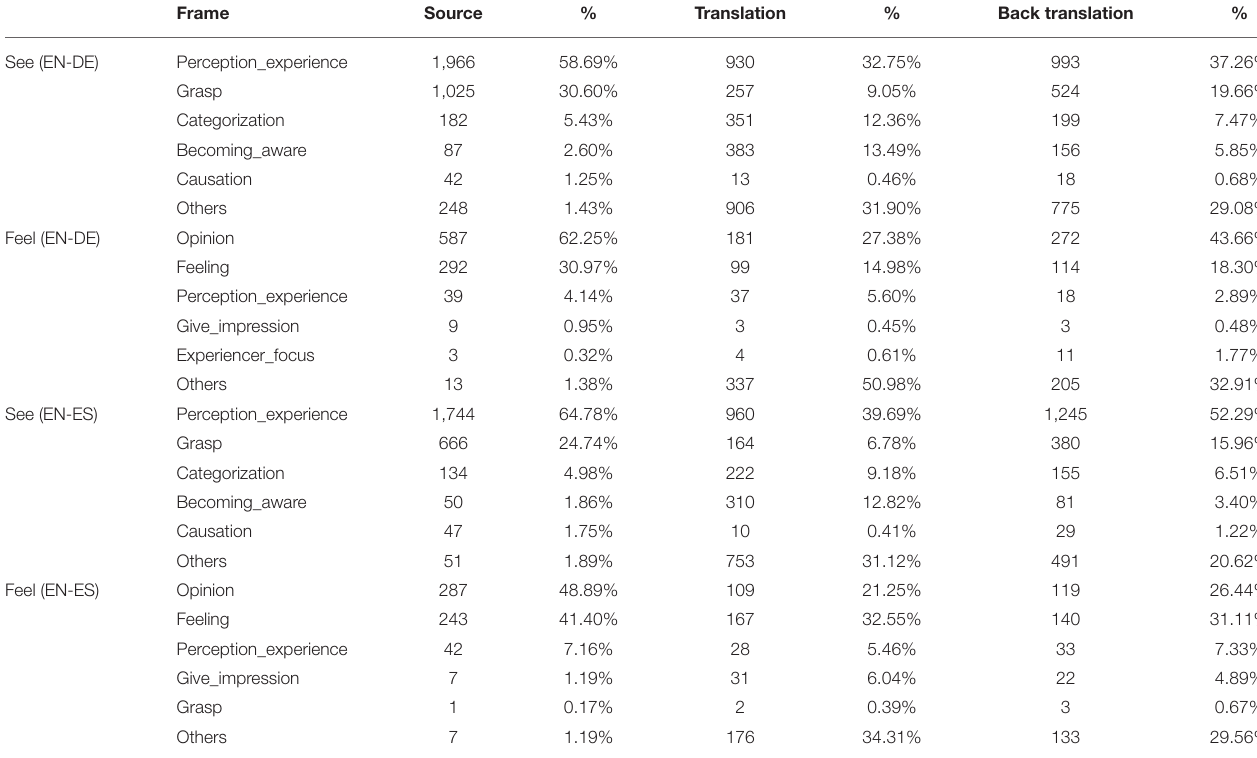
TABLE 2 | Most frequently detected and labeled frames in each data set.